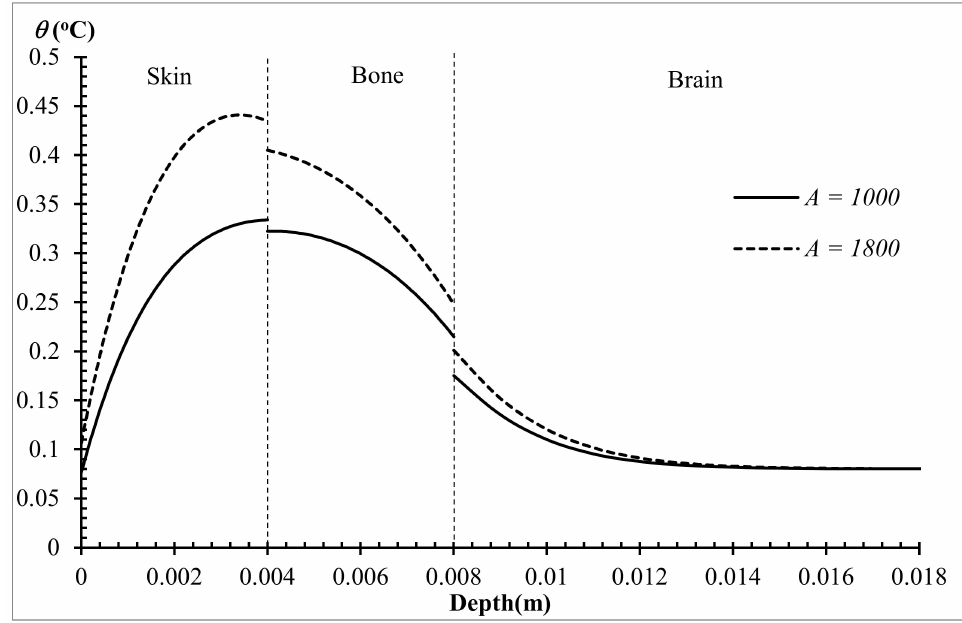
Figure 12. The dynamical temperature increment with different values of power transmission on an adult’s head.